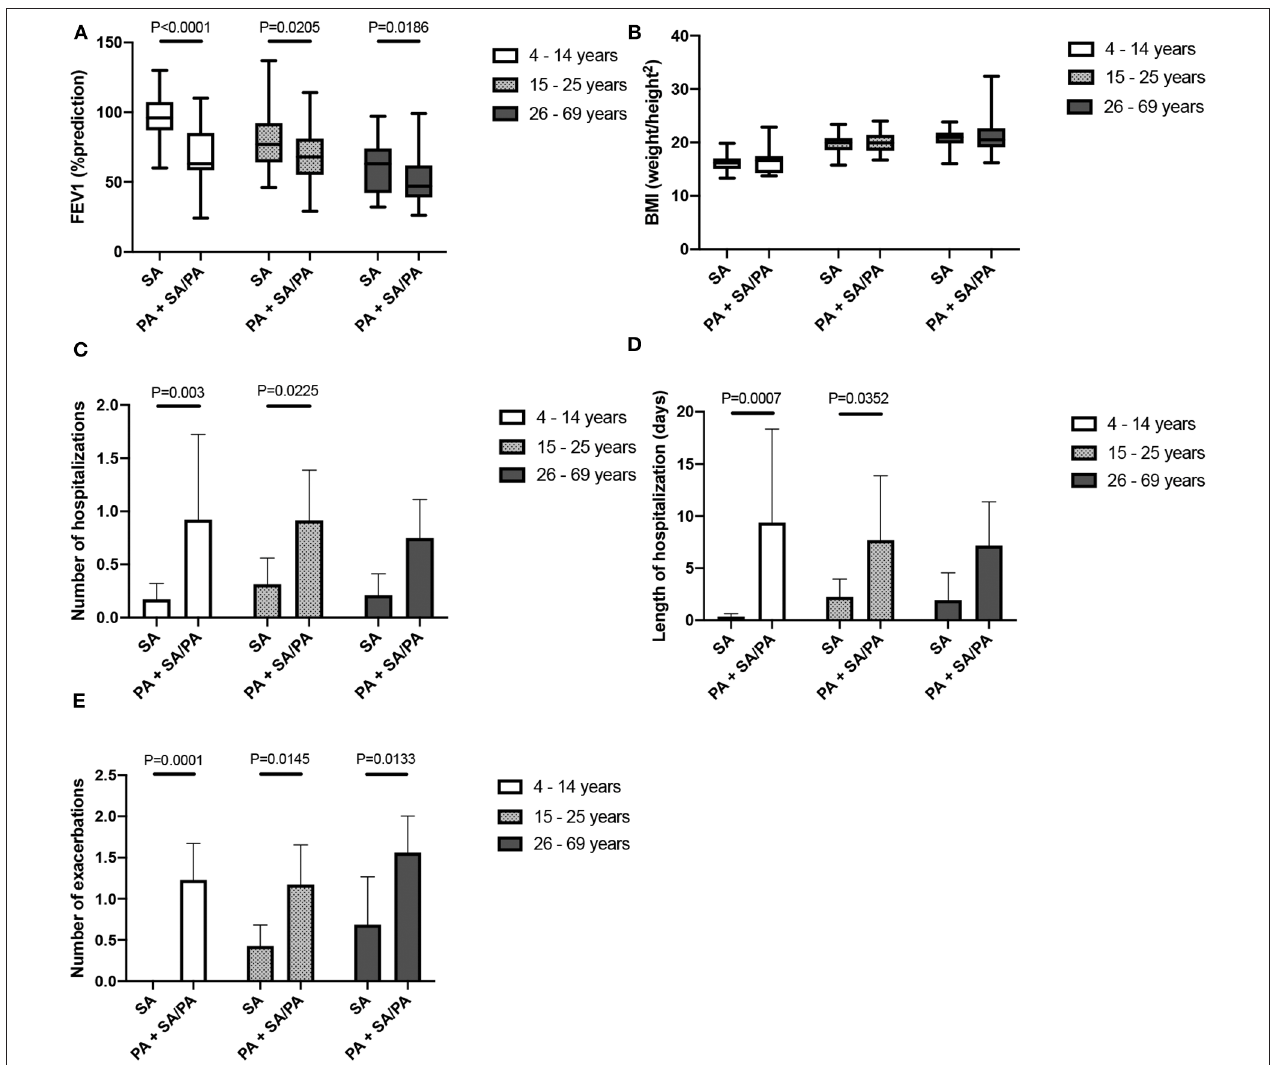
FIGURE 2 | Comparison between SA mono-infected (SA) and PA mono-or co- infected (PA) groups within three age classes of patients. FEV1 (A) , BMI (B) , number of hospitalization (C) , length of hospitalization (D) and number of exarcerbations (E) are represented. A Mann-Whitney Wilcoxon non-parametric test was